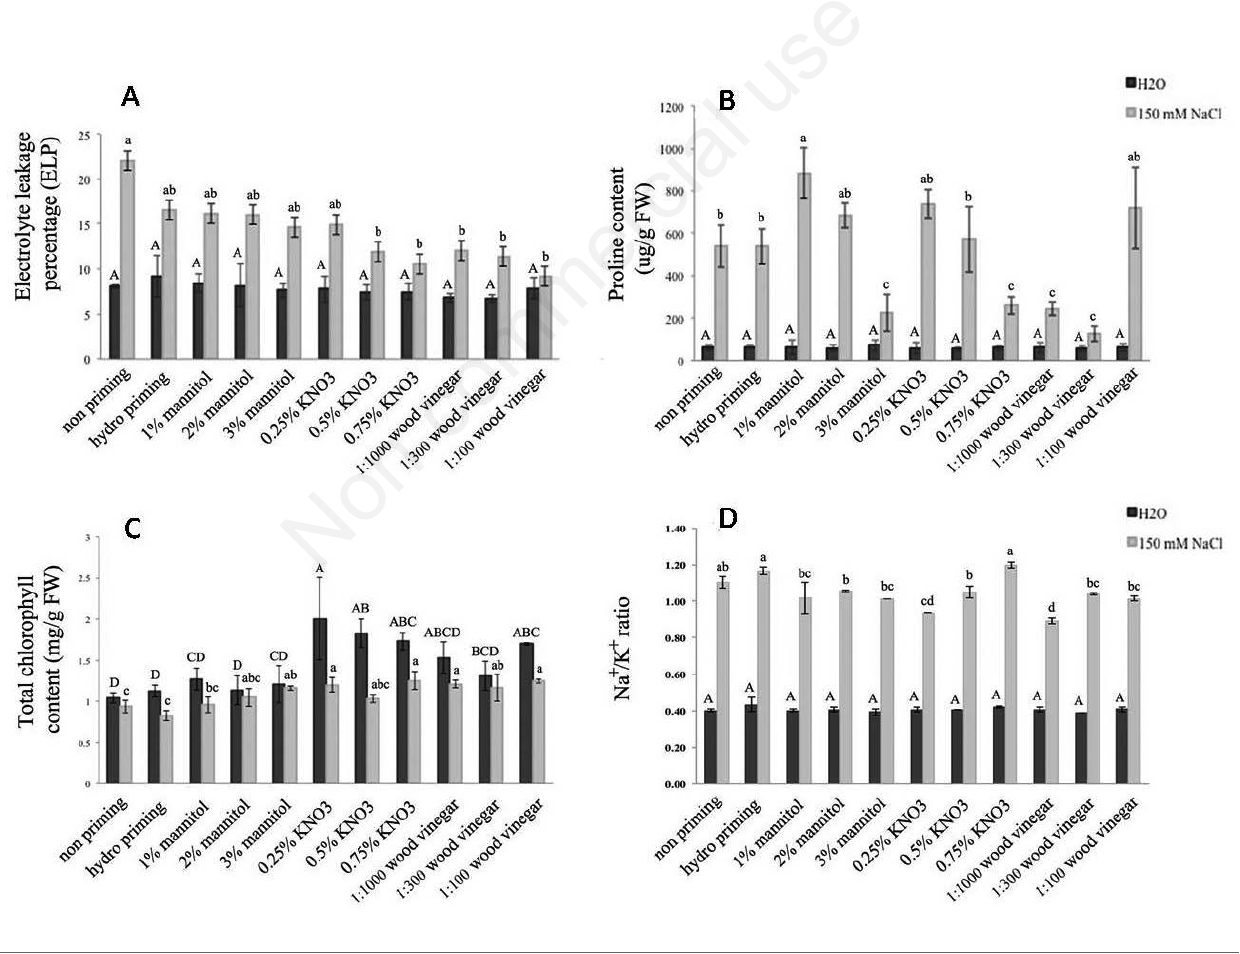
Figure 2. Electrolyte leakage percentage (A), proline content (B), chlorophyll content (C) and Na + /K + ratio (D) of 4-week-old rice plants raised from nonprimed seeds and seeds primed with water, mannitol (1%, 2% and 3%), KNO vinegar (1:1000, 1:300 and 1:100 dilutions) and grown under non-saline and saline condition (150 mM NaCl). Means sharing same alphabets (uppercasee, non-saline condition; lowercase; saline condition) were not significantly different P ≤